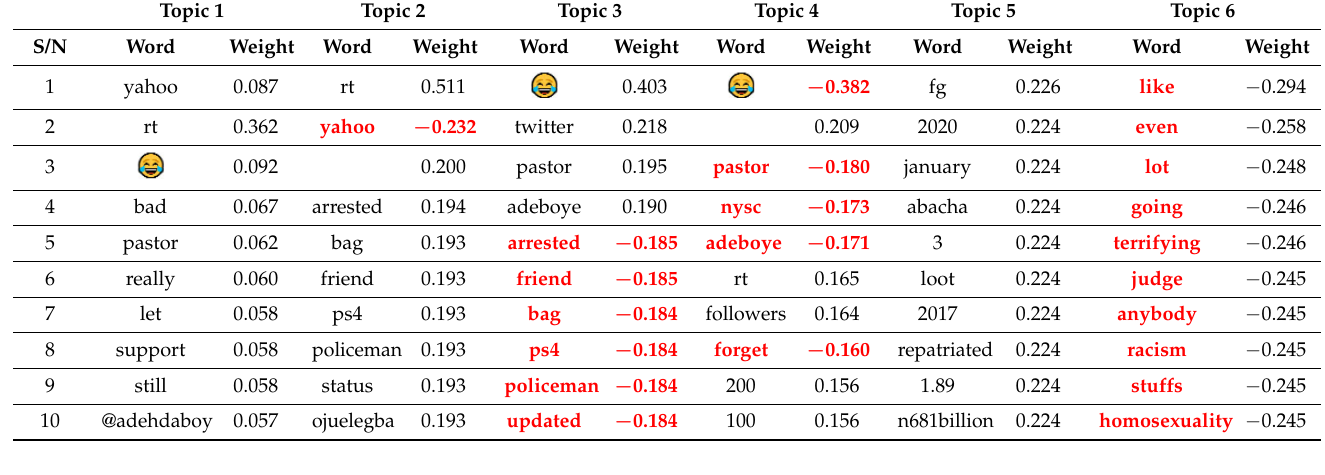
Table 6. LSI selected topics with top 10 words and weights.